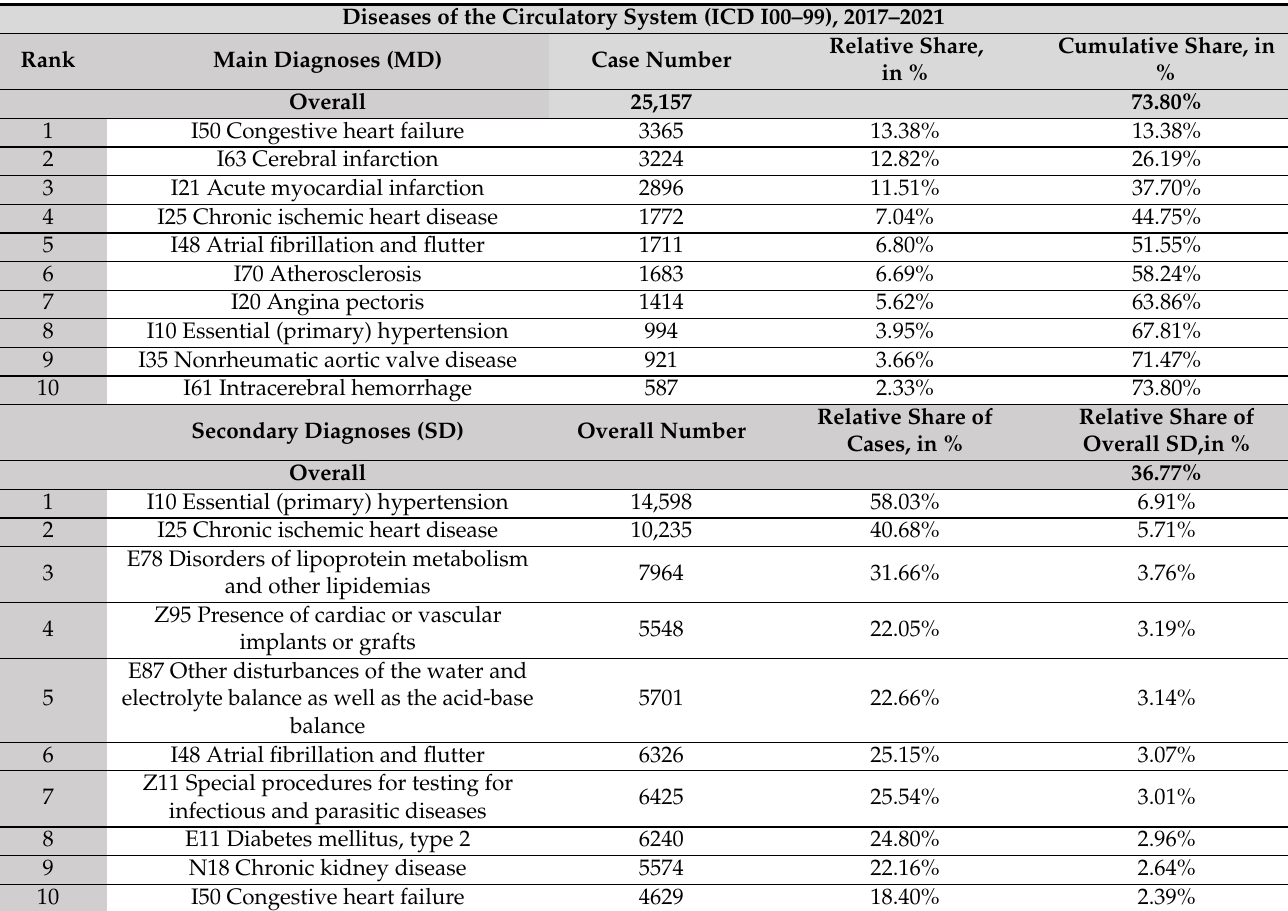
Table 2. Most common MD and SD of hospitalized patients with cardiovascular disease, 2017–2021.